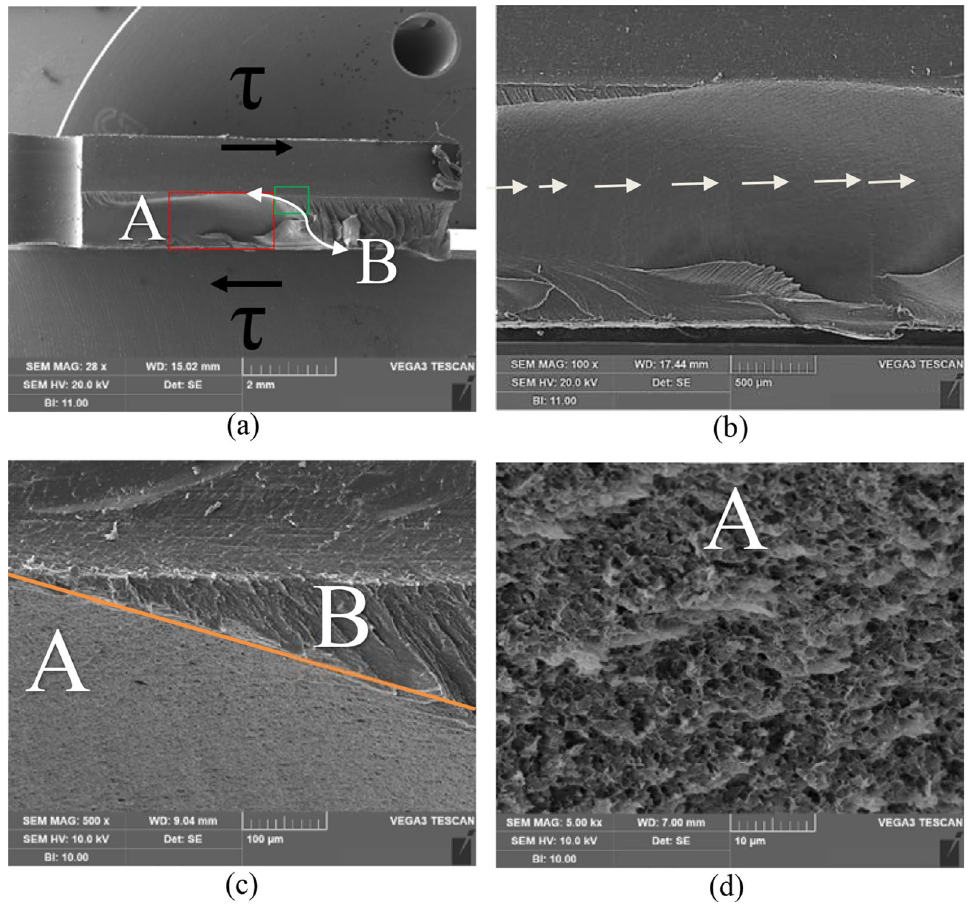
Figure 7. SEM images showing fracture surfaces of HIPS after shear test at ( a ) ×28, ( b ) enlarged view of red rectangle inside ( a ) at ×100, ( c ) enlarged view of green rectangle inside ( a ) at ×500 and ( d ) enlarged view of region A at